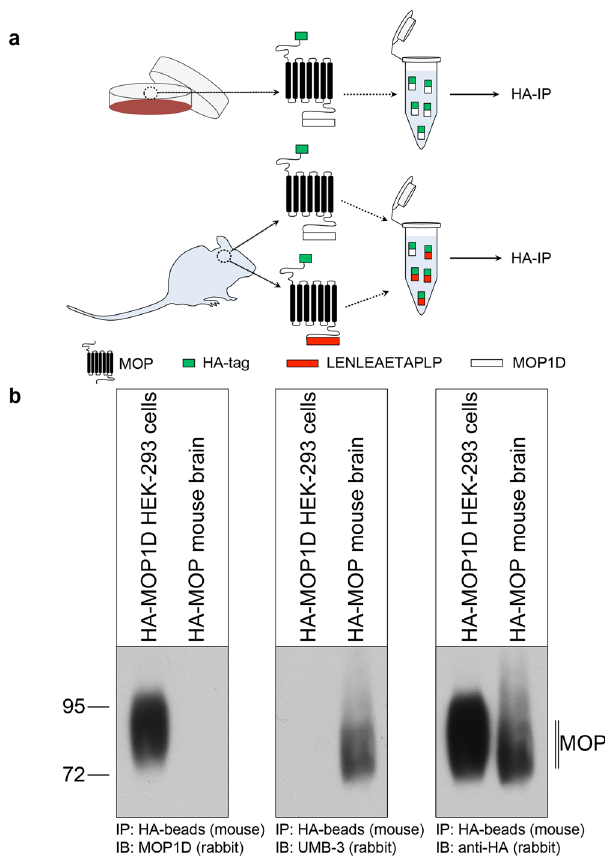
Fig. 5 Western blot analysis of MOP1D expression in vivo. a Schematic representation of the experimental procedure b HEK293 cells stably expressing HA-MOP1D, as well as brain lysates from HA-MOP mice, were immunoblotted with anti-MOP1D antibody (left panel), UMB-3 (central panel), or anti-HA antibody (right panel). Representative data from one of four independent experiments are shown. Positions of molecular mass markers are indicated on the left (in kDa). Blots are representative of four independent